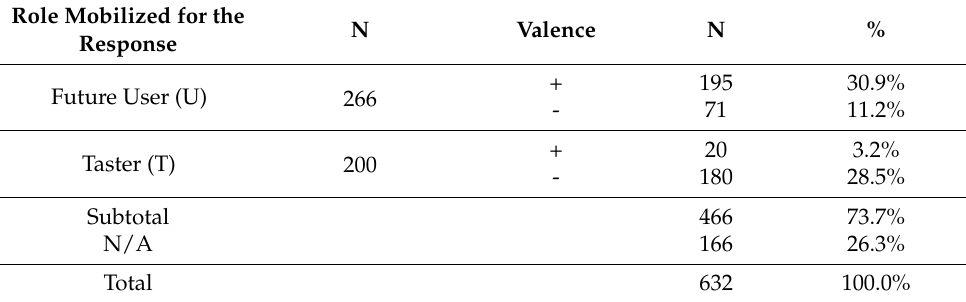
Table 2. Categorization of qualitative data—SHERPAM project. Role Mobilized for